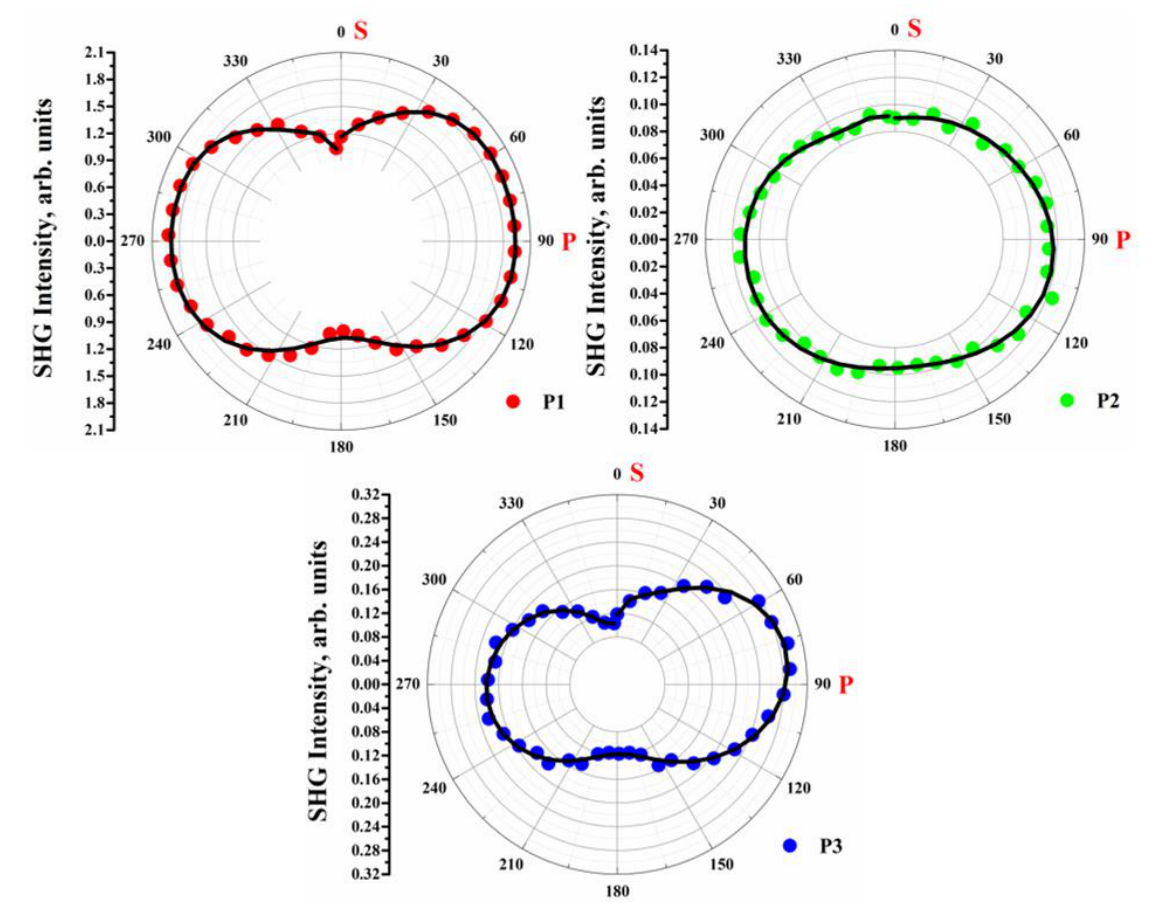
Figure 5. Dependence of generated second harmonic intensities on output laser polarization.